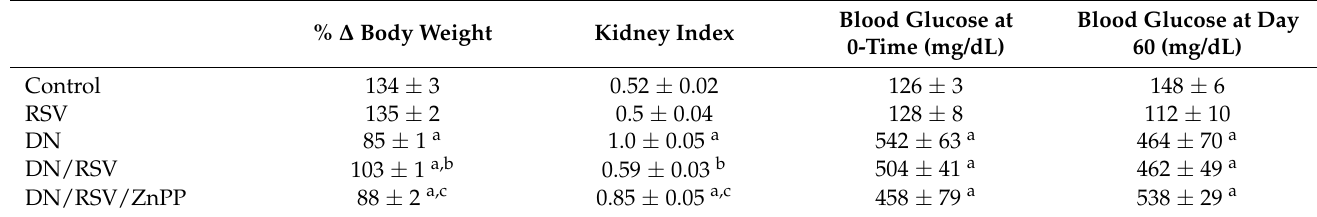
Table 1. Effect of rosuvastatin (RSV) on change in body weight, kidney index and blood glucose in diabetic nephropathy (DN) in rats.